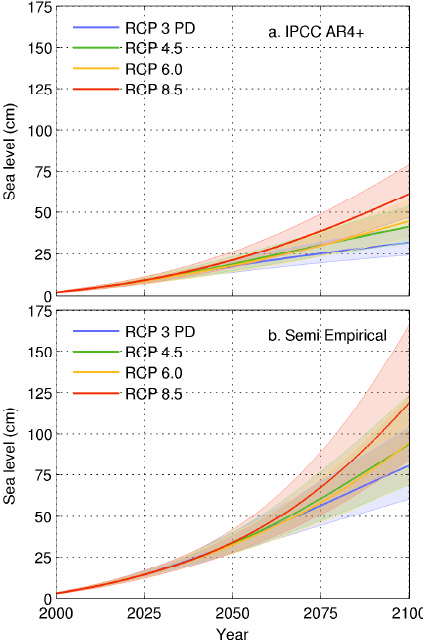
Fig. 6. Projected global mean sea level rise during the 21st century for the four RCP scenarios, in (a) the IPCCAR4 + case and (b) the semi-empirical case. The shading indicates the likely range (16th to 84th percentiles).